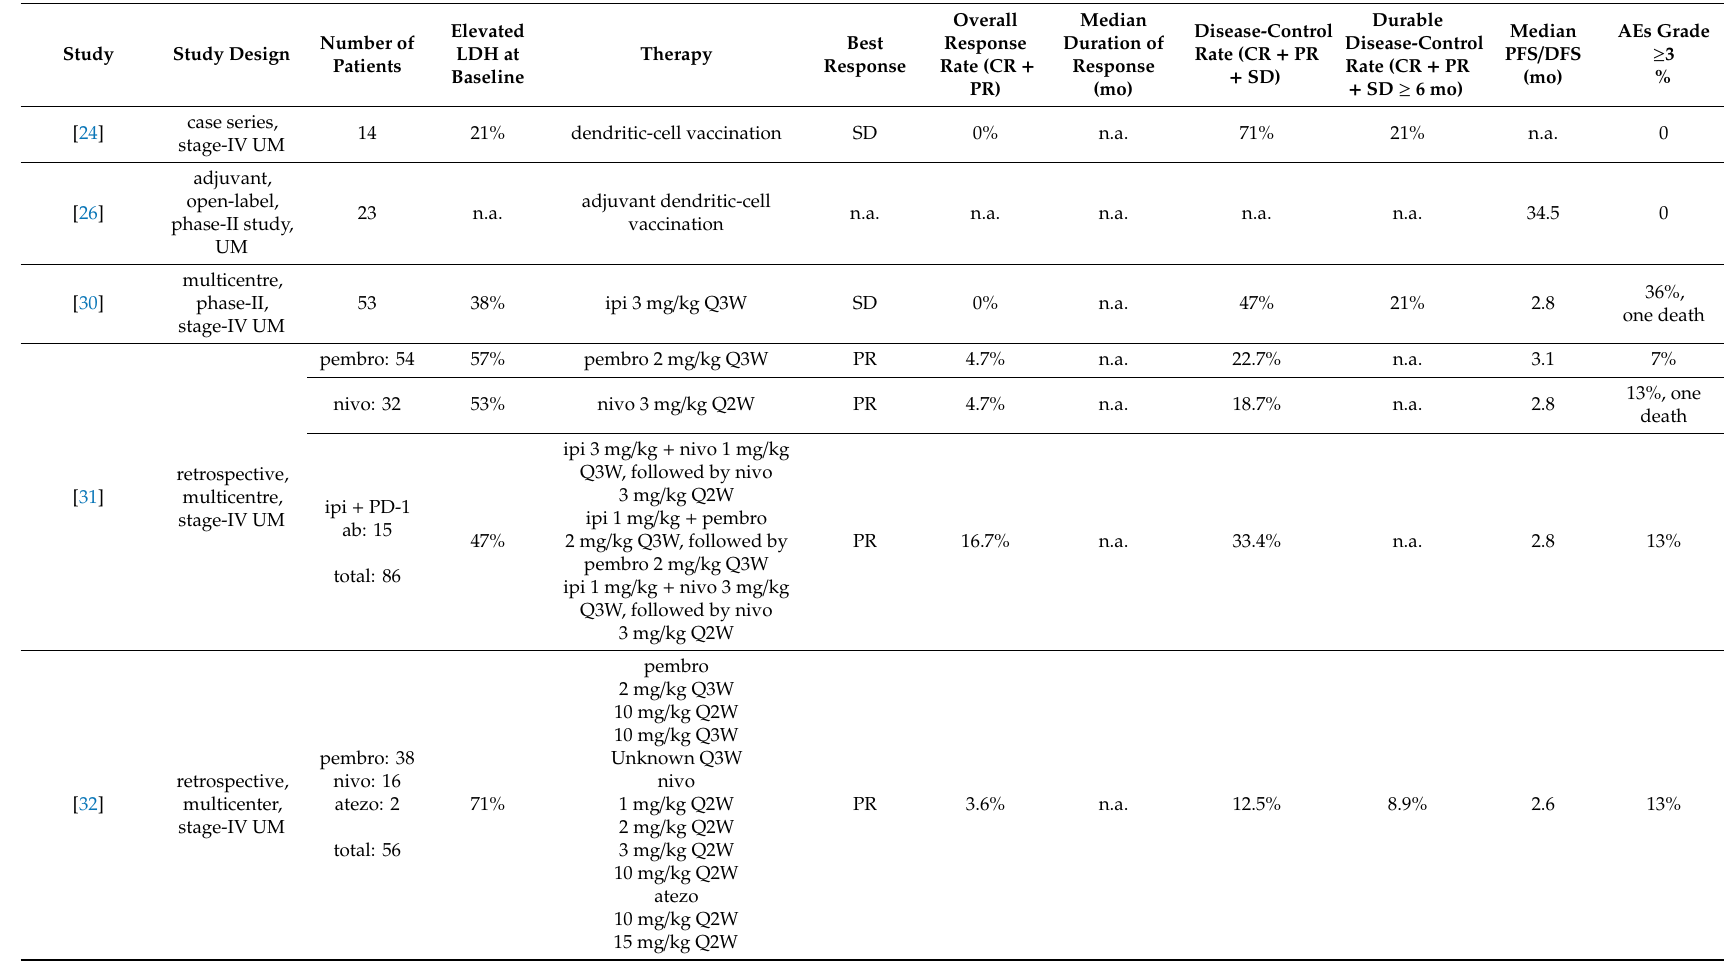
Table 1. Summary of immunotherapy studies for uveal melanoma